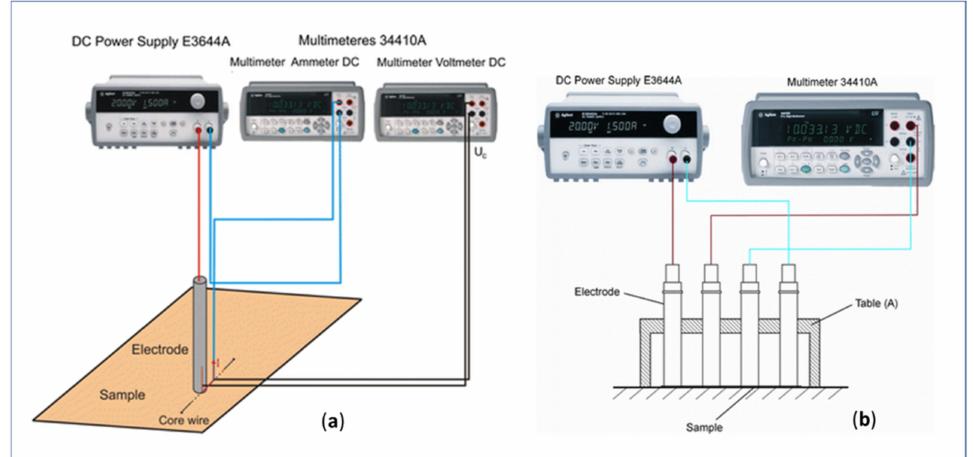
Figure 5. The measuring systems for: ( a ) determination of a contact resistance, and ( b ) multi- variant textile resistance measurements (reprinted under the terms of the CC BY Creative Commons Attribution 4.0 International License from Ref. [78] Copyright 2022 Springer